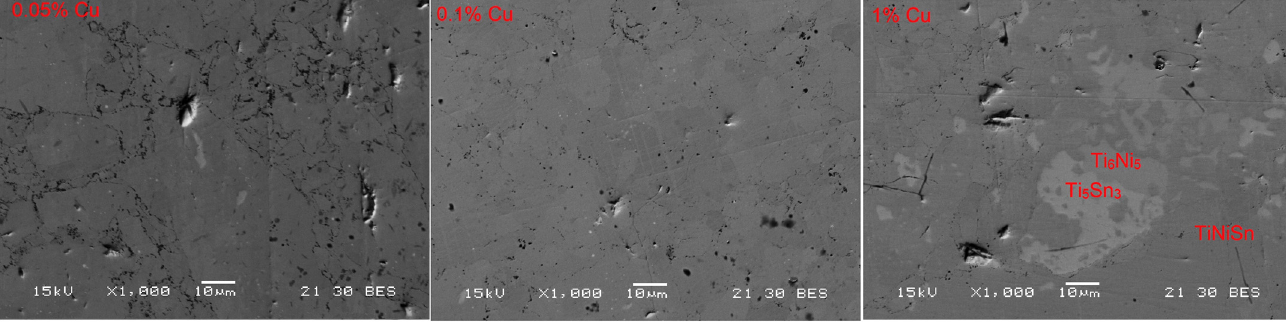
Figure 4. Backscattered SEM image of the 0.05%, 0.1%, and 1% Cu-doped samples.